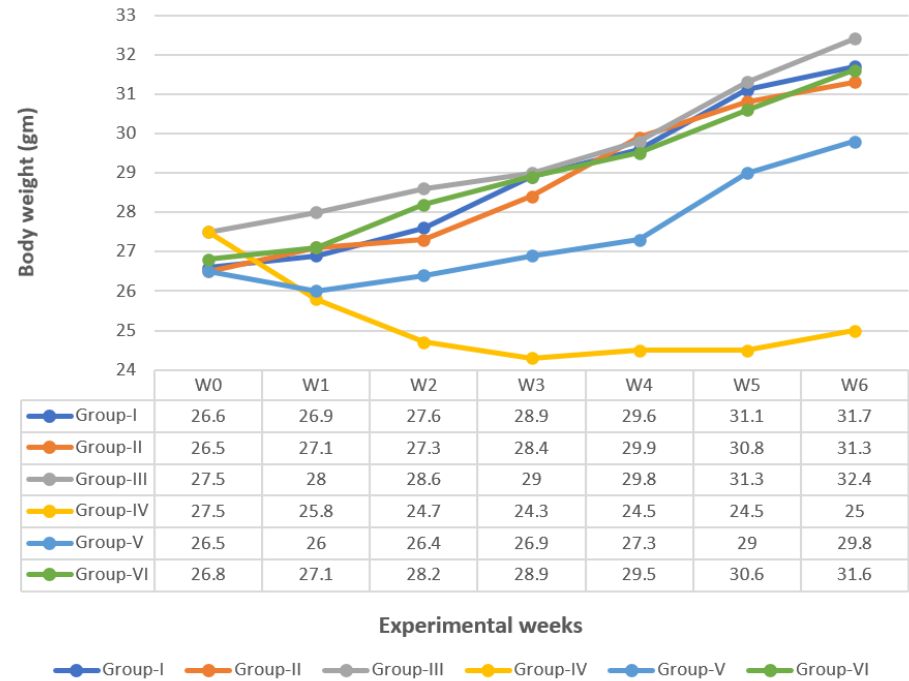
Figure 1. Changes in body weights of different groups under study.